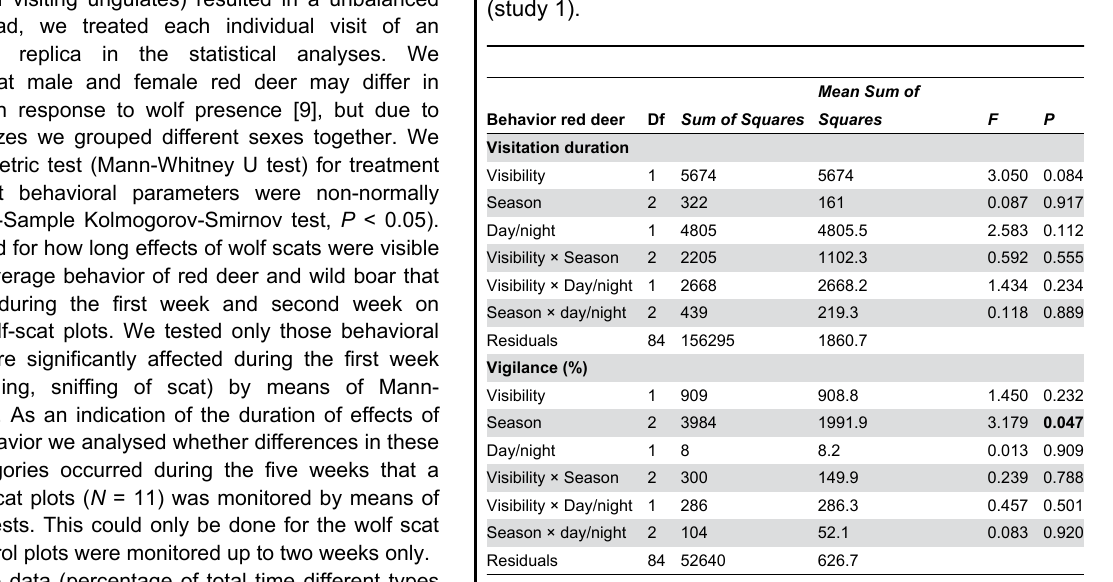
Table 1. Behavior of red deer in relation to habitat visibility (study